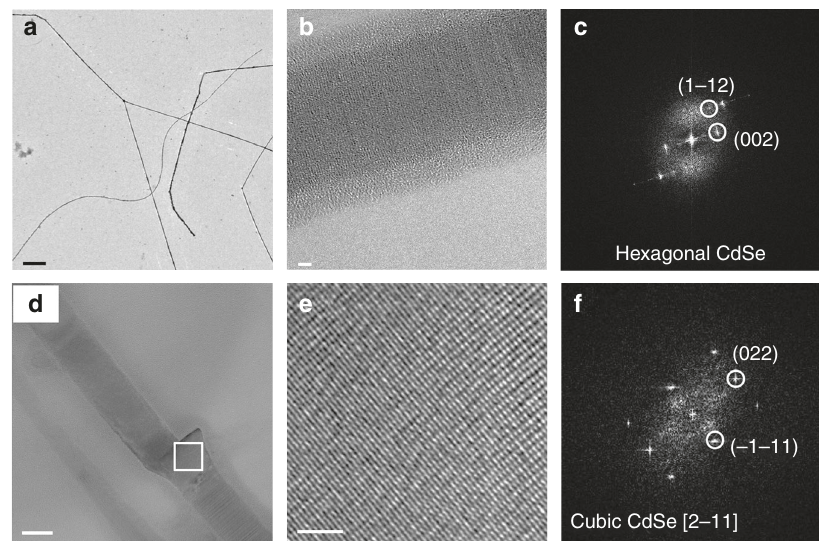
Fig. 2 Transmission electron microscopy analysis. a Low-magni fi cation TEM image of the CdSe NWs fabricated by seeded solution synthesis. Scale bar is 1 µ m. b HRTEM image of the CdSe NWs showing defects in crystal lattice structure. Scale bar is 2 nm. c Corresponding FFT demonstrating that the wire is oriented along the [110] zone axis, and elongated in the < 001 > direction of the wurtzite structure (ICSD: 415784). d HRTEM image of the CdSe/Cu 2 Se heterojunction, scale bar is 20 nm. e Magni fi ed view of the CdSe region marked with a box in d , showing that the defects were eliminated after electron irradiation. Scale bar is 2 nm. A detailed analysis of defects in irradiated and non-irradiated regions is presented in the Supplementary Figure 1. f The corresponding FFT showing the cubic crystal structure of CdSe (ICSD: 53954)